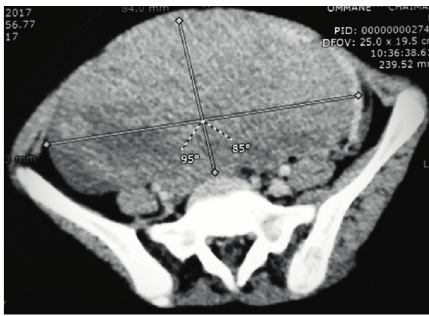
Figure 2: Contrast-enhanced CT shows a heterogeneous density abdomino-pelvic tumor.